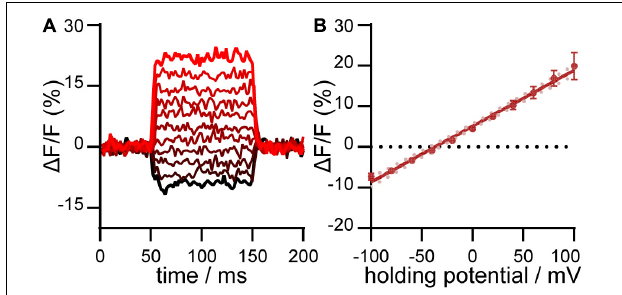
FIGURE 4 | Voltage sensitivity of RhoVR-Halo in HEK293T cells expressing HaloTag-CD4. (A) Plot of (cid:49) F/F vs. time for a single HEK293T cell expressing HaloTag-CD4 and stained with RhoVR-Halo. The HEK293T cell was held at –60 mV and then stepped through hyperpolarizing and depolarizing potentials, in 20 mV increments, from –100 mV to +100 mV. (B) Plot of (cid:49) F/F vs. potential in mV. Data are mean ± standard error of the mean for n = 7 separate cells. Solid line is the line of best fit, and pink dots are 95% confidence